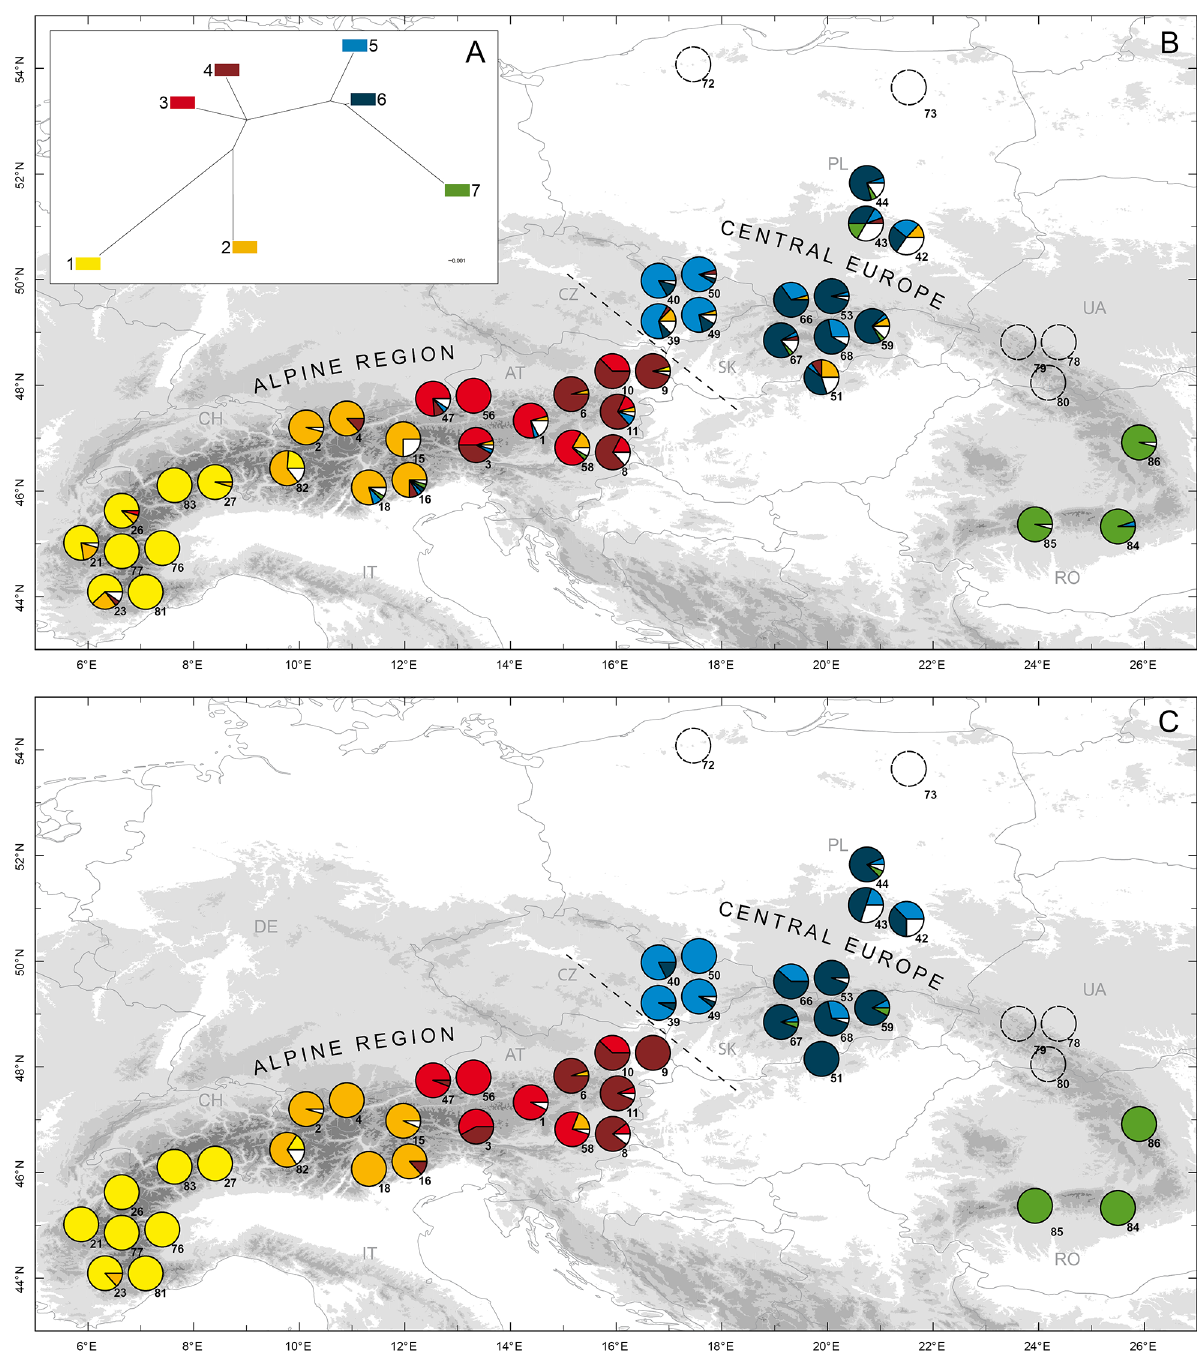
Fig 2. Nuclear clusters detected by S TRUCTURE . Neighbor joining tree (A) and distribution of the seven SSR clusters before (B) and after (C) removing presumably non-native genotypes. In (A) each rectangle represents a cluster. In (B) and (C) pie charts represent cluster composition of the 40 presumably native populations and 5 populations sampled outside the range (n°72, 73, 78, 79 and 80) (~24 individuals/population). Individuals with q values > 0.5 are colored, the remaining ones are in